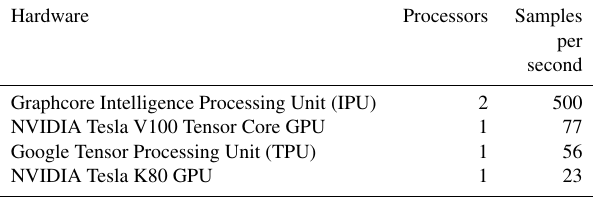
Table 4. DeepPrecip model training throughput comparisons run- ning on Tensorflow (v2.4.3) using a batch size of 128 samples on different hardware. Note that 2 IPUs were used in comparison to 1 GPU/TPU to equalize average computation costs when training DeepPrecip using each piece of hardware.